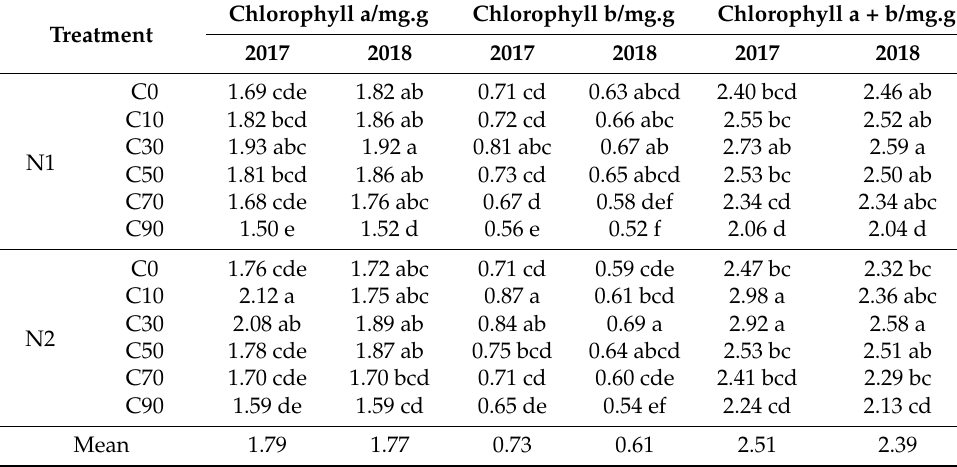
Table 3. The effects of biochar on photosynthetic pigments in tomato leaves under low (N1) and normal (N2) nitrogen fertilization in 2017 and 2018. Different lowercase letters denote significant differences among treatment means at the 0.05 level by Duncan’s MRT method. Chlorophyll a/mg.g Chlorophyll Treatment